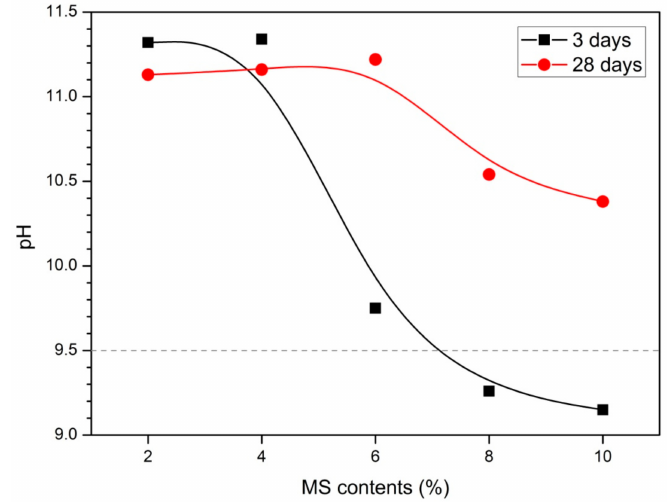
Figure 5. pH values for paste.